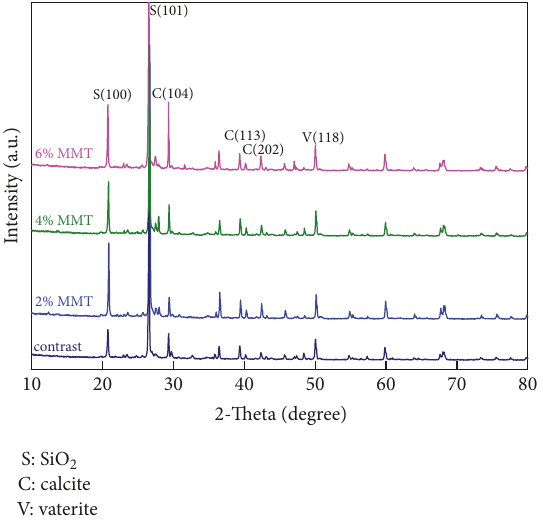
Figure 10: XRD patterns of cemented sand column.